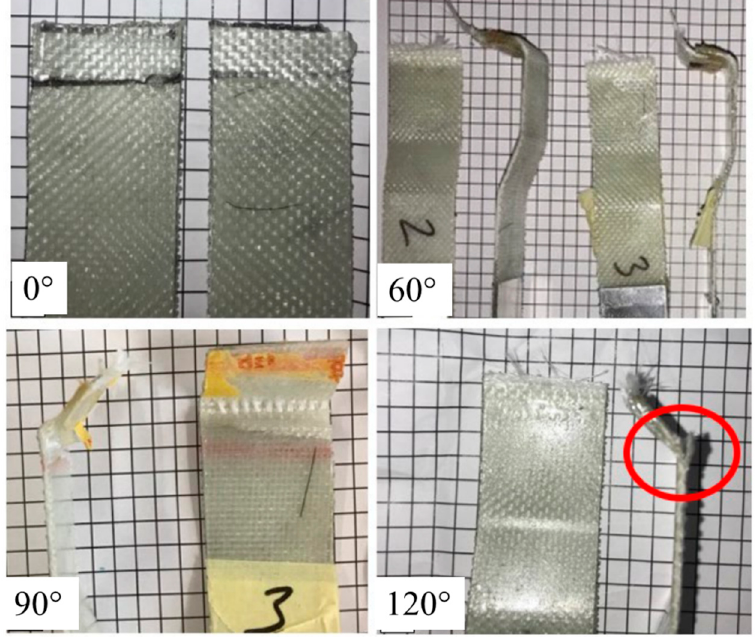
Figure 9. Images of the failures that occurred within each test specimen: single-lap joint 0°; 60° bond angle; 90° bond angle; and 120° bond angle.